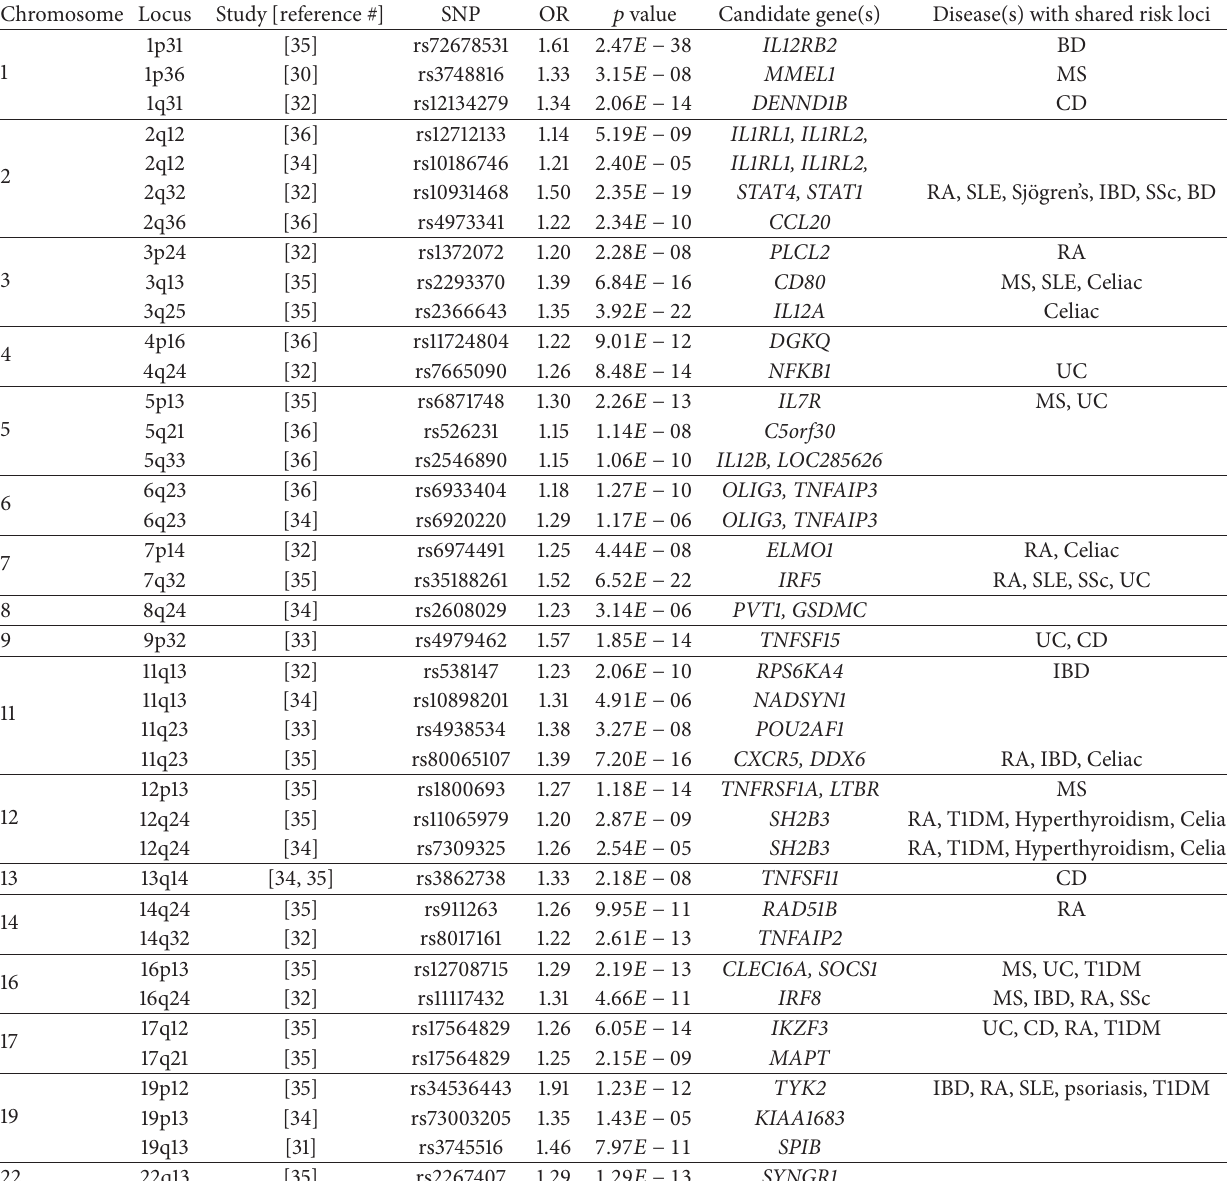
Table 3: Non-HLA risk loci identified through GWAS as associated with PBC at the genome-wide level of significance. Chromosome Locus Study [ reference #